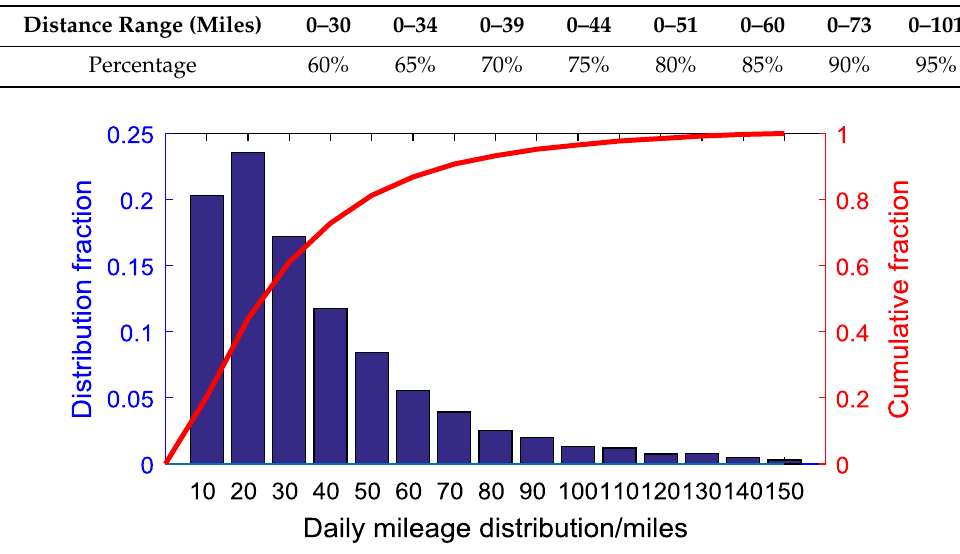
Figure 2. Histograms of daily mileage and cumulative percentage. Table 1. Driving distance distribution.